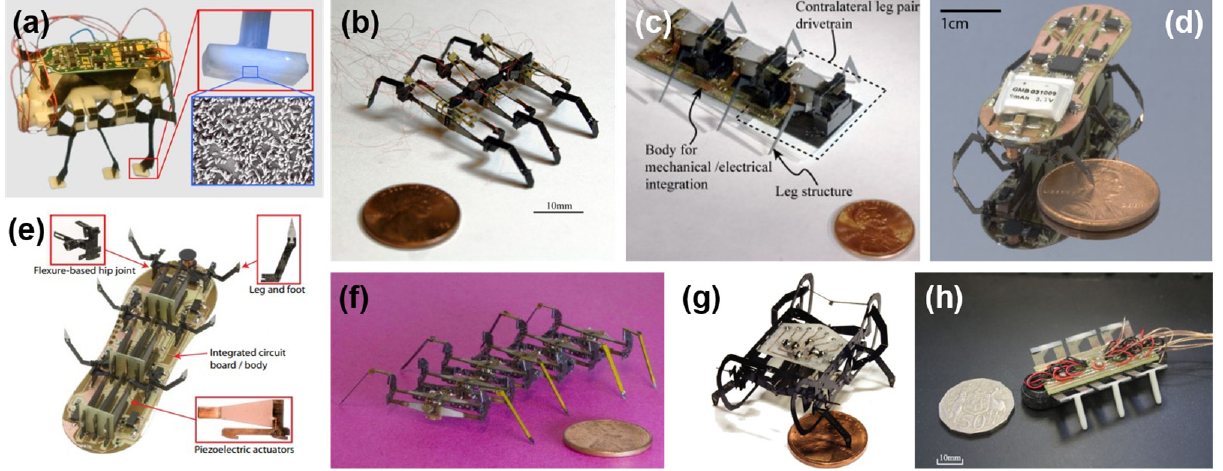
Figure 2. ( a ) Crawler with zoomed-view of fibers in the feet. Reprinted with permission from Ref. [13]. Copyright 2006, IEEE. ( b ) Centipede-like microrobot. Reprinted with permission from Ref. [37]. Copyright 2011, Springer. ( c ) HAMR 2 . Reprinted with permission from Ref. [35]. Copyright 2010, IEEE. ( d ) Top-view and ( e ) bottom-view of HAMR 3 . Reprinted with permission from Ref. [36]. Copyright 2011, IEEE. ( f ) Centipede millirobot. Reprinted with permission from Ref. [14]. Copyright 2013, IEEE. ( g ) HAMR-VP. Reprinted with permission from Ref. [39]. Copyright 2014, SAGE. ( h ) MinRAR. Reprinted with permission from Ref. [40]. Copyright 2017, IEEE .